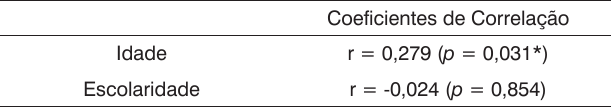
Tabela 2. Coeficientes de correlação de Spearman da latência do P300 (ms) com idade e escolaridade.